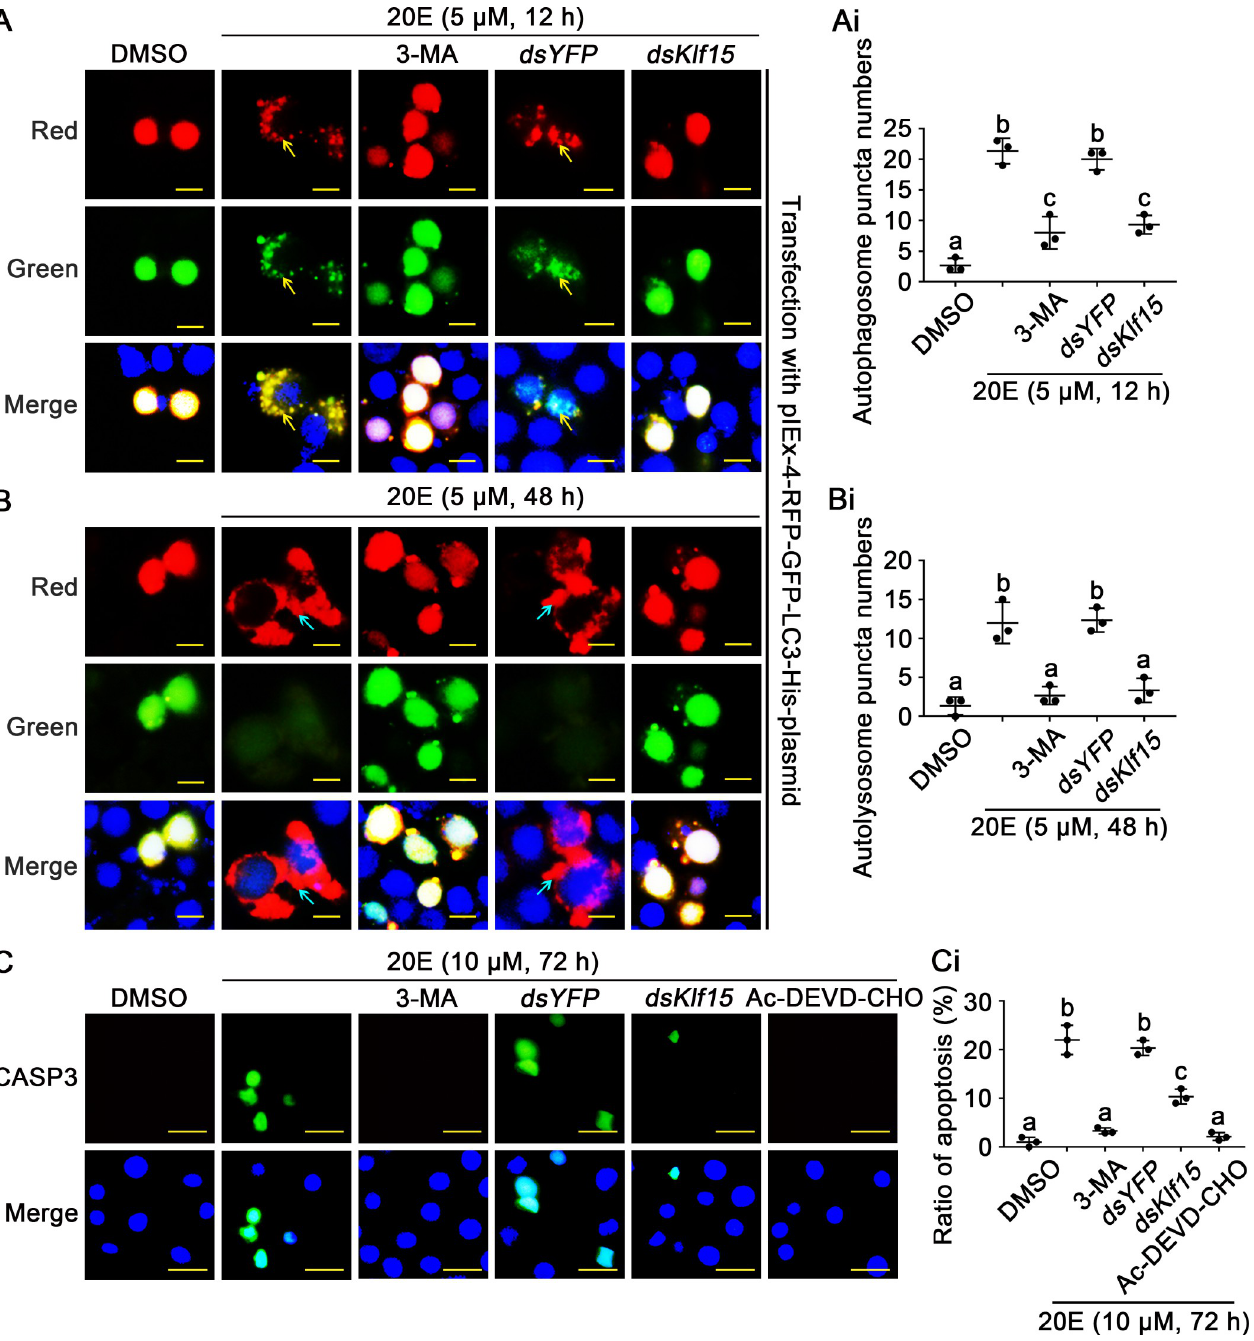
Fig 4. KLF15 promoted autophagy and apoptosis as detected by autophagic flux and CASP3 activity. A and B. The autophagic flux were detected in HaEpi cells when Klf15 was knocked down, dsYFP was used as the control. 3-MA (10 μ M) is an autophagosome formation inhibitor; the yellow bars represented 20 μ m. The yellow arrows represented autophagosome puncta. The blue arrows represented autolysosome puncta. Ai and Bi. Counted the number of autophagosome puncta and autolysosome puncta in successfully transfected with pIEx-GFP-RFP-LC3 cells. C. After knocked down Klf15 in HaEpi cells, examination of apoptosis by the addition of active CASP3, Ac-DEVD-CHO is a CASP3 inhibitor, the bars represented 50 μ m. Ci. Quantification apoptotic cells in total from C.